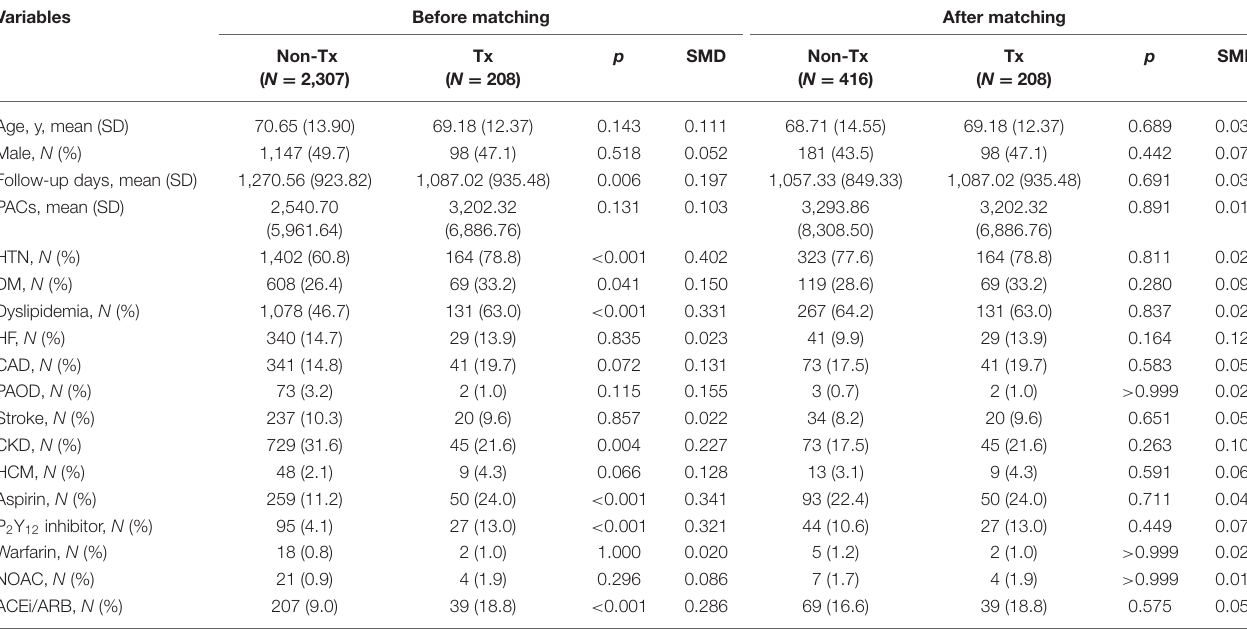
TABLE 1 | Demographic and clinical characteristics of patients with a high burden of PACs in the treatment and non-treatment groups before and after propensity score matching. Variables Before matching After matching Non-Tx ( N =